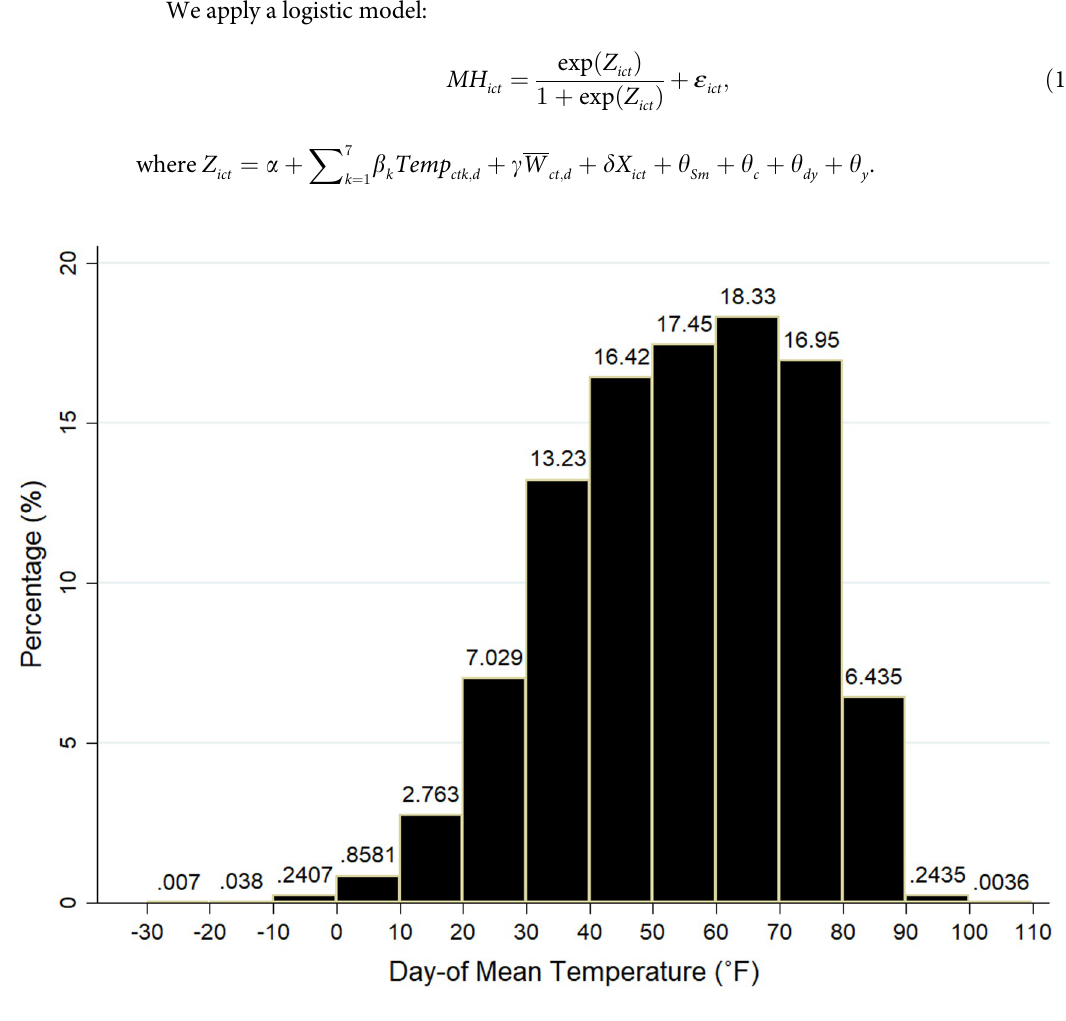
Fig 2. Distribution of interview date mean temperature. Data source for temperature: PRISM Climate Group of Oregon State University. Combined with BRFSS data for the period 1993–2010.